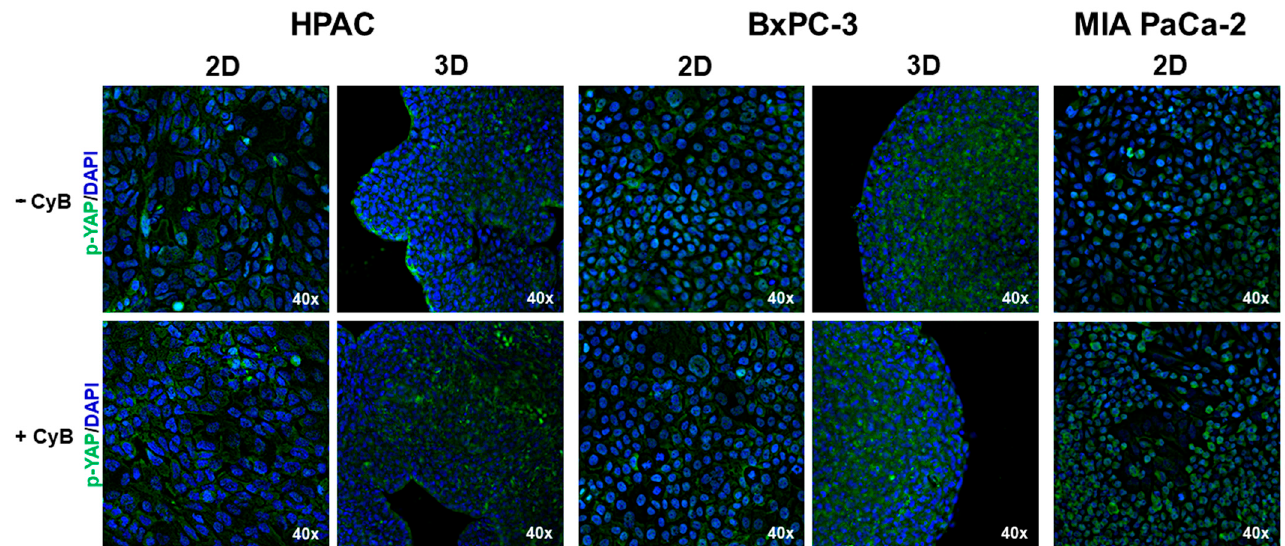
Figure 10. Immunofluorescence analysis for p-YAP (green) in PDAC cells cultured in 2D monolayers and 3D spheroids. The micrographs show that in HPAC and BxPC-3 cells p-YAP expression is mostly cytoplasmic in both 2D and 3D cell cultures. By contrast, MIA PaCa-2 cells grown in 2D monolayer revealed a different pattern of expression. Indeed, the more fibroblastoid subpopulation is characterized by a lower p-YAP expression, whereas the more epithelial cells revealed a more intense and cytoplasmic expression, according to the different cell adhesion on the plastic substrate. Original magnification: 40×.